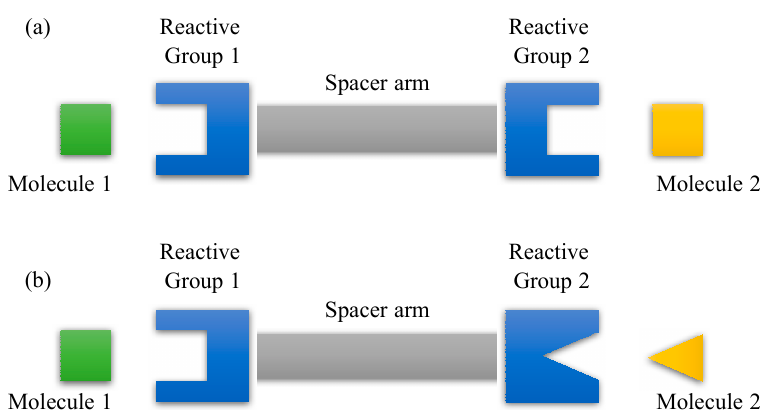
Figure 4. General design of crosslinking agent. ( a ) Homobifunctional crosslinker with identical reactive groups at the end of spacer arm and ( b ) heterofunctional crosslinker with two different reactive groups at the either end of spacer arm.